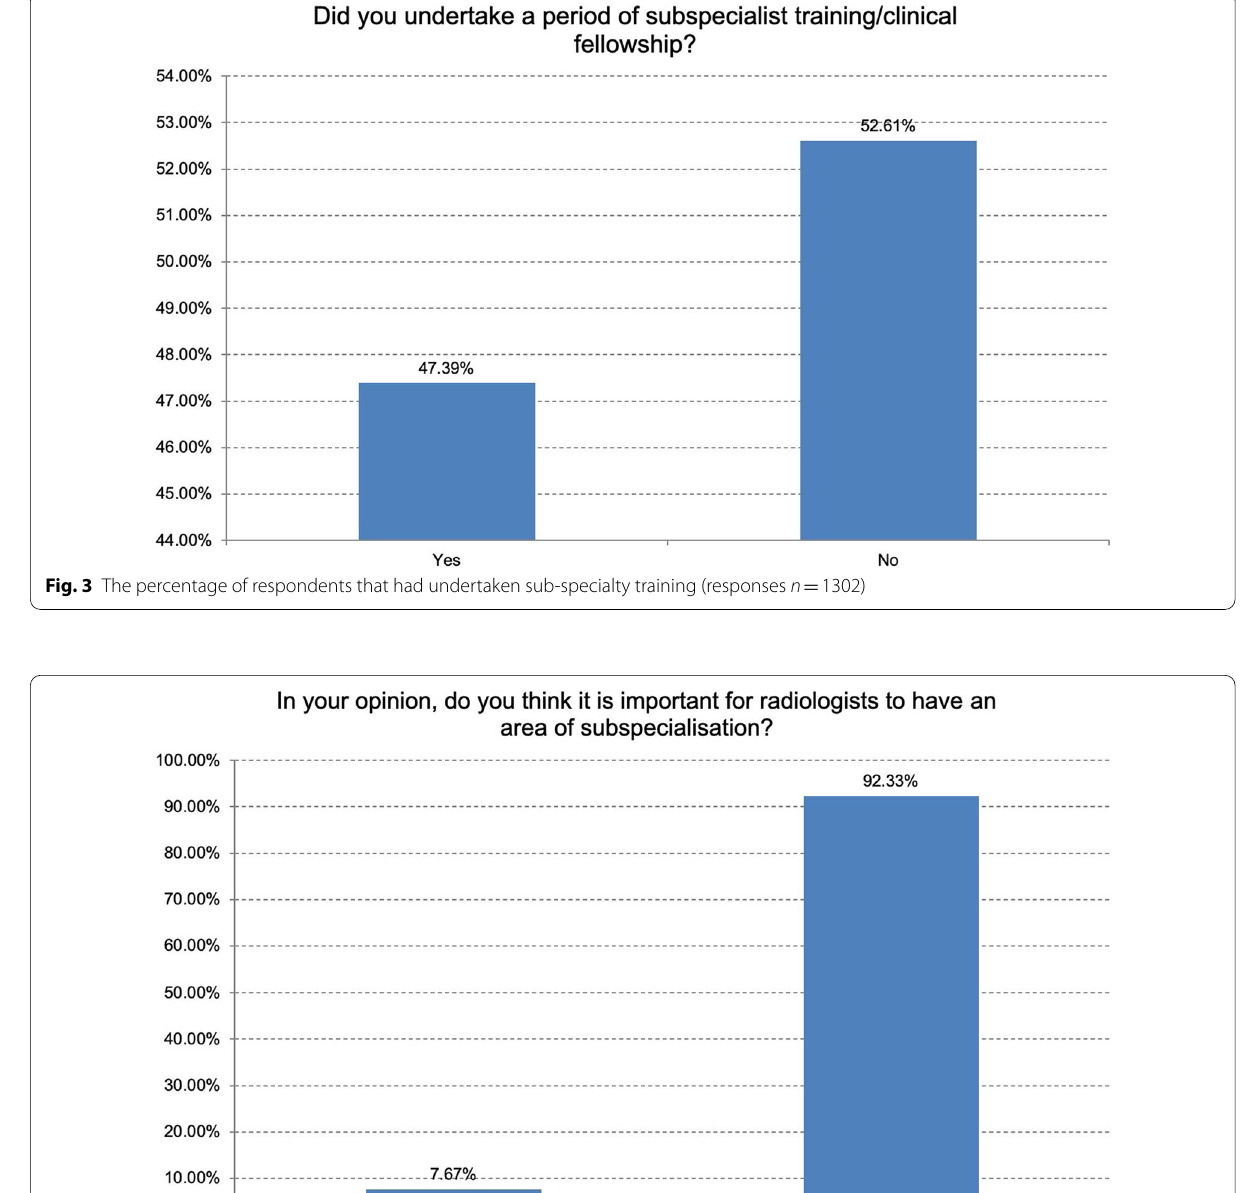
Fig. 4 The percentage of respondents that think sub-specialty training is important (responses n